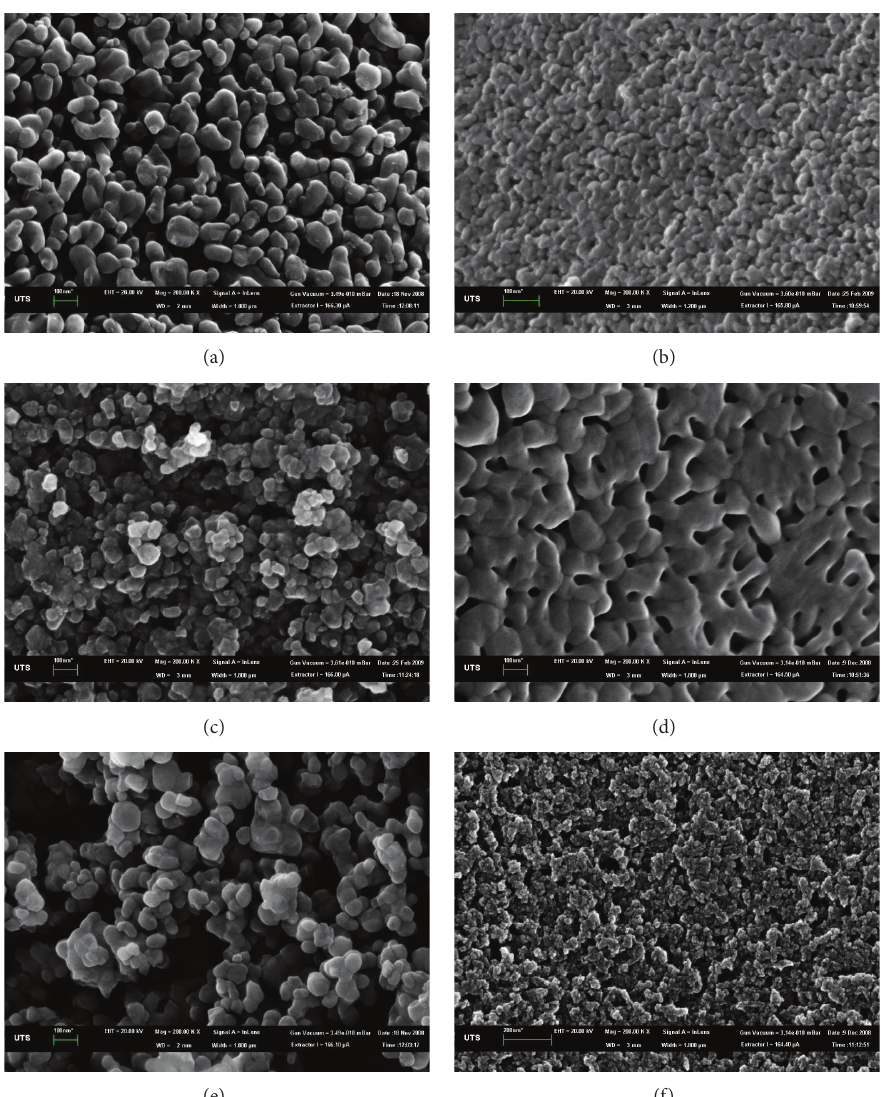
Figure 13: SEM picture of the nanocrystalline sorbents used for packing radionuclide generator columns. Sorbents: (a) ZiSorb, (b) TiSorb, (c) SnSorb, (d) ZT-11, (e) ZT-31, and (f) organic-polymer resin OASIS-HLB (Waters) of average pore diameter 80 ˚A (for a comparison purpose)